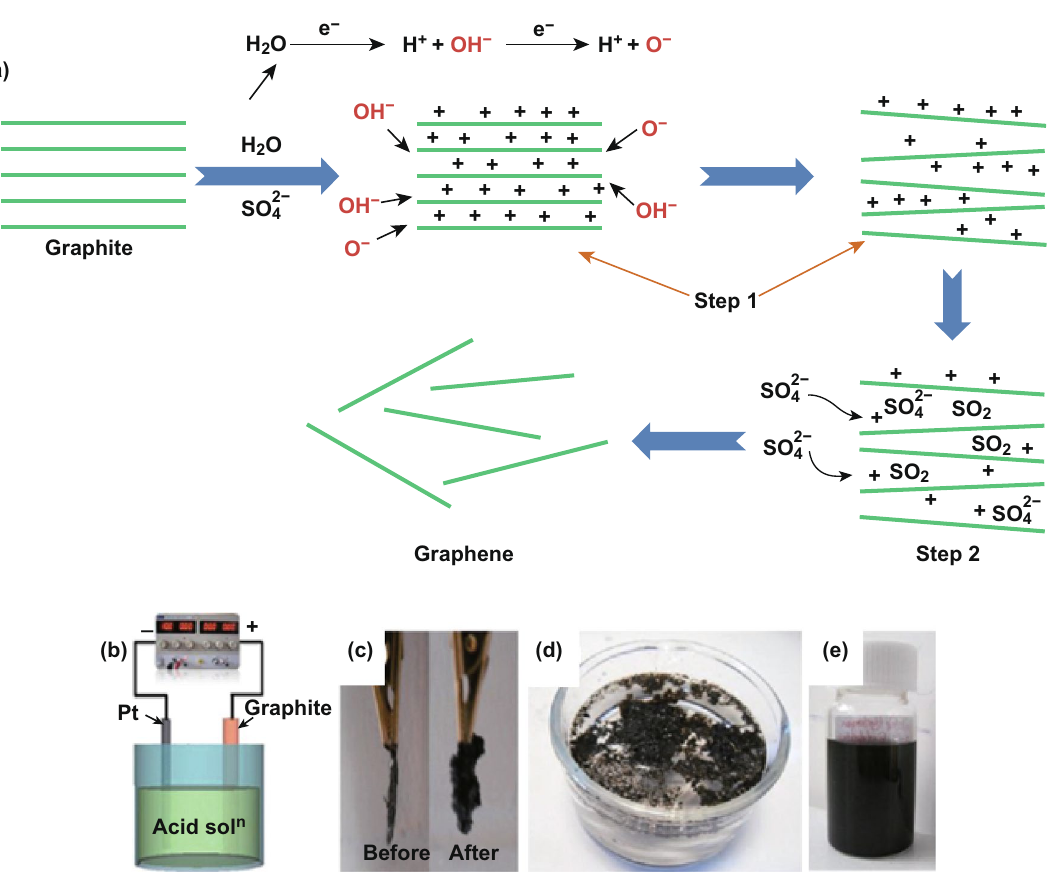
Fig. 7 a Schemes of the microscopic processes of graphite exfoliation in H 2 SO 4 aqueous electrolytes. Step 1: edge opening by waterborne radicals; Step 2: SO 42− intercalation and exfoliation. b Experimental setup for the graphite exfoliation. c Photographs of the exfoliated elec‑ trodes before and after exfoliation. d Exfoliated graphene floating on an electrolyte. e Dispersed graphene sheets in dimethylformamide solution. Adapted from Ref. [84] with